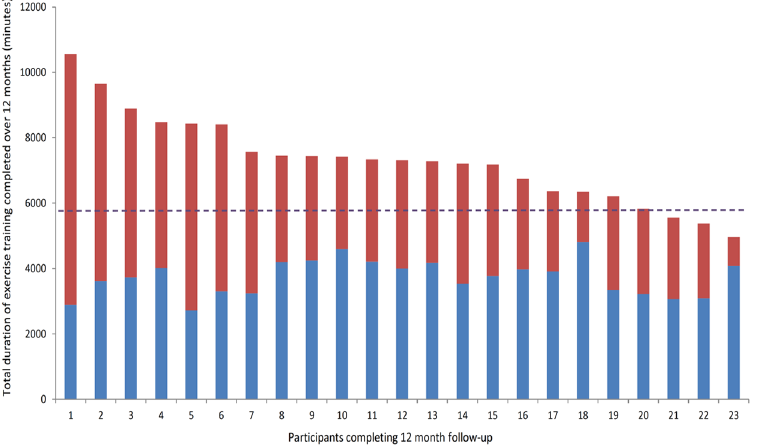
Figure 2. Total exercise behaviour over 12 months in minutes for all 23 exercise training participants, with blue bars = supervised exercise and red bars = independent exercise. Dashed line = 75% adherence or 5850 minutes in total.